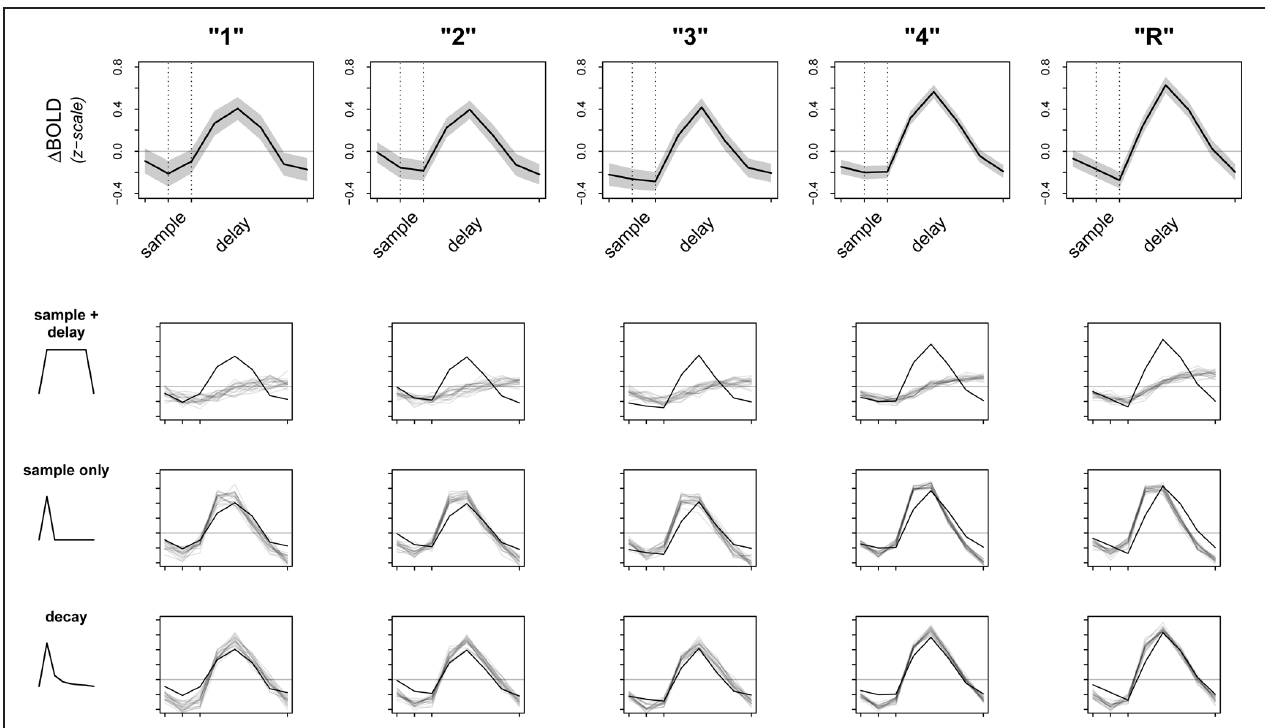
FIGURE 3 | Observed data and model fit of three encoding models. The top row shows the raw data from a 5 mm sphere around the peak voxel in L. PHC, averaged over all participants and all trials. Whole time series are z -scored within participant prior to averaging to transform the data to a common scale; the horizontal gray line represents the mean of the raw time series. Dotted lines correspond to the onsets of sample and delay periods, respectively. Note that due to the sluggishness of the hemodynamic